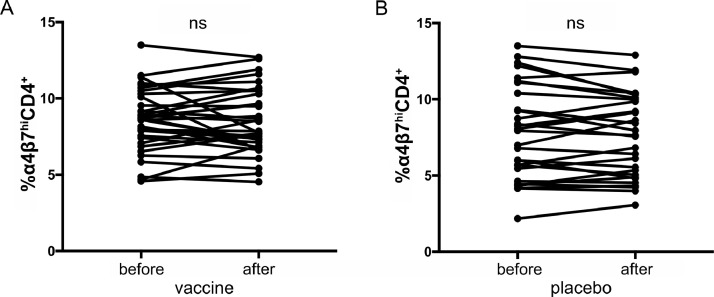
Levels of α4β7hiCD4+ T cells before and after vaccine or placebo administration. Proportion of α4β7hiCD4+ T cells in individuals from the HVTN 505 vaccine study before and after administration of the vaccine (A) or placebo (B) is shown. No significant changes were observed in either arm. (n.s, nonsignificant, by Wilcoxon signed-rank test)